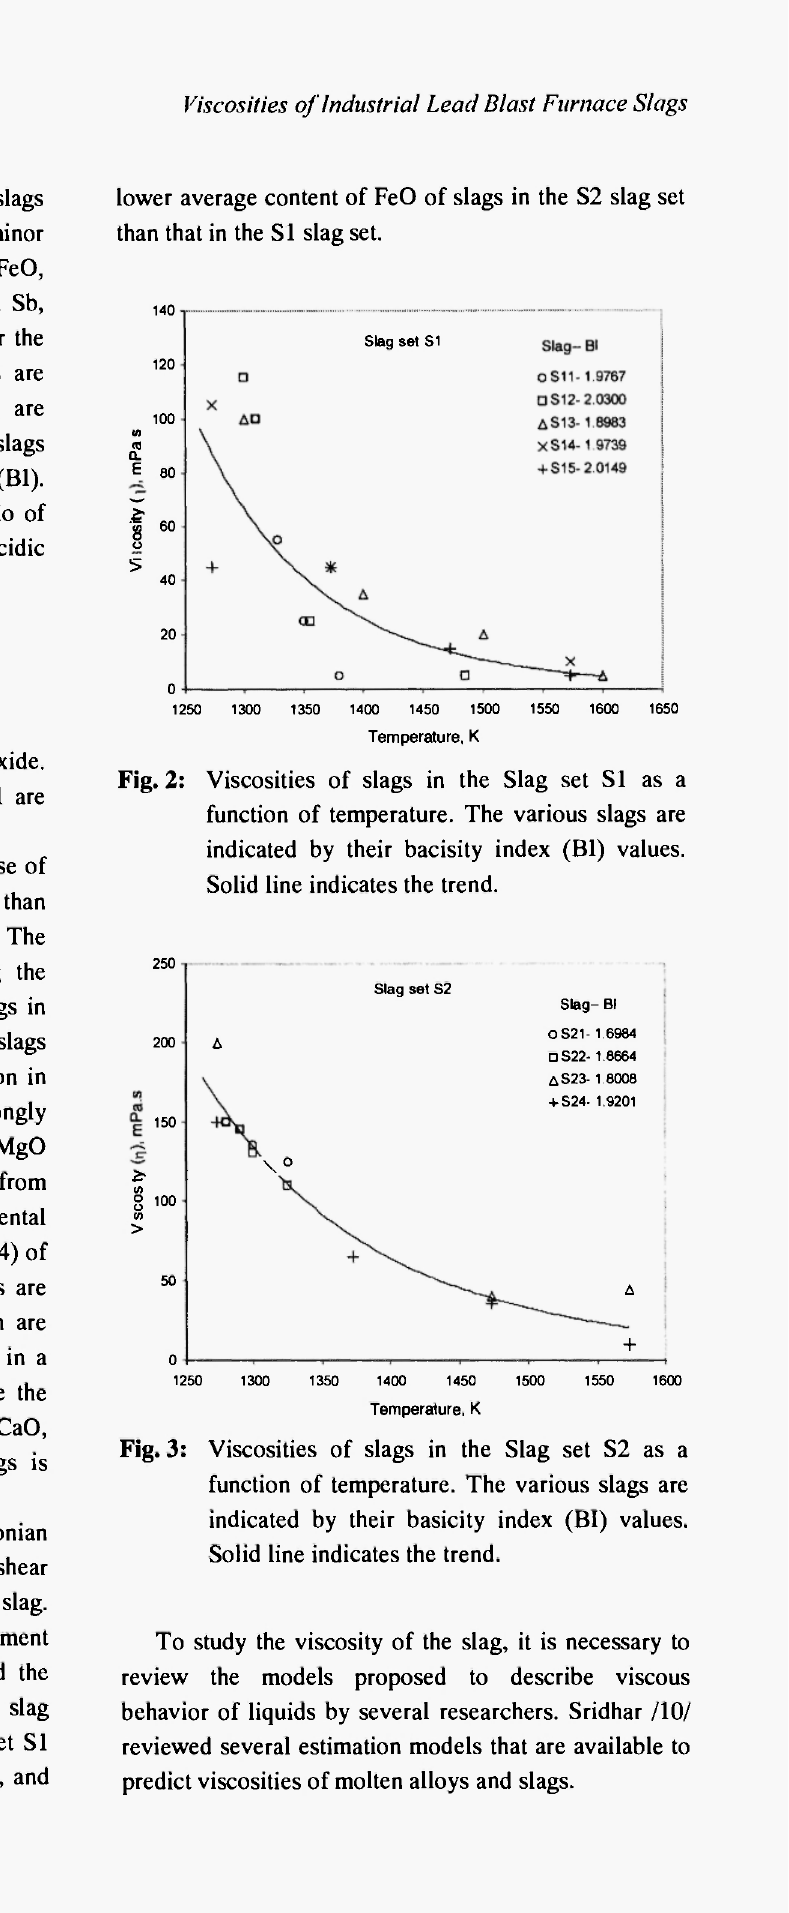
Fig. 3: Viscosities of slags in the Slag set S2 as a function of temperature. The various slags are indicated by their basicity index (BI) values. Solid line indicates the